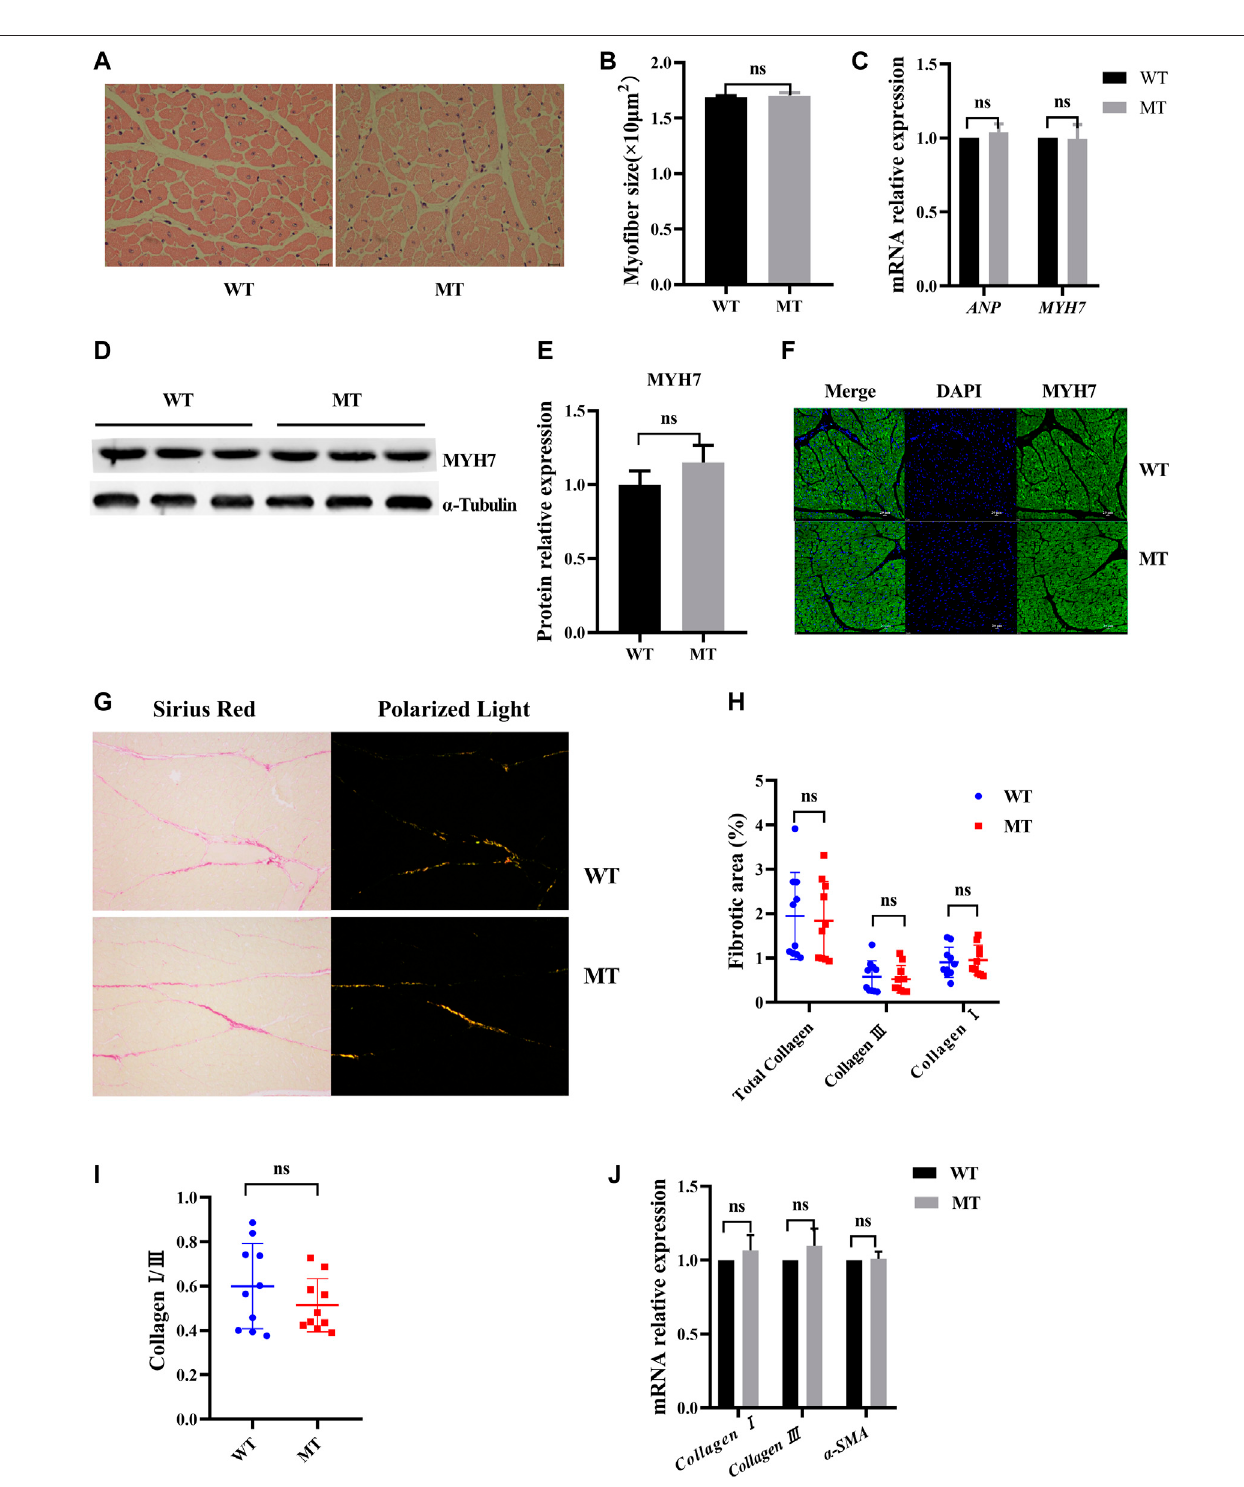
FIGURE 2 | Myostatin mutation did not cause cardiac histology change. (A) Hematoxylin and eosin (HE) staining of heart tissue samples (400×). (B) Calculated cross-sectional area of heart samples ( n > 100 cells for each group). (C) mRNA levels of the hypertrophic markers. (D,E) Expression of MYH7 protein in heart of MT and WT cattle. (F) Representative expression of MYH7 immuno fl uorescence images of heart (green, MYH7; blue, nuclei; scale bar, 25 μ m). (G) Representative images of SiriusRed-stainedsectionsandpolarizedlightmicroscopyfromMTandWTcattle. (H,I) Analysisofcardiac fi brosis,andinpolarizedlightcollagentypeI(red-yellow) and collagentype III(green) inMTand WT cattle. (J) mRNAlevels ofthe fi brosismarkers.All dataarepresentedasmean±SD. Compared withthe WTgroup, * p < 0.05, ** p < 0.01, ns: no signi fi cant; t -tests were used to calculate the p -values.